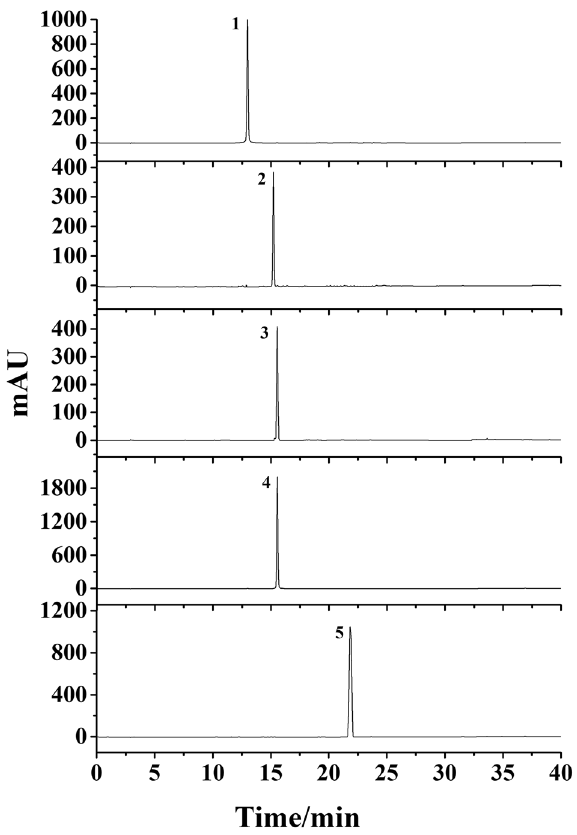
Figure 4. Purity detection of the five compounds by HPLC. Conditions: column, Platisil ODS-C18 analytical column (250 mm × 4.6 mm i.d., 5 μm); mobile phase, 0.1% acid water ( A ) and methanol ( B ), gradient